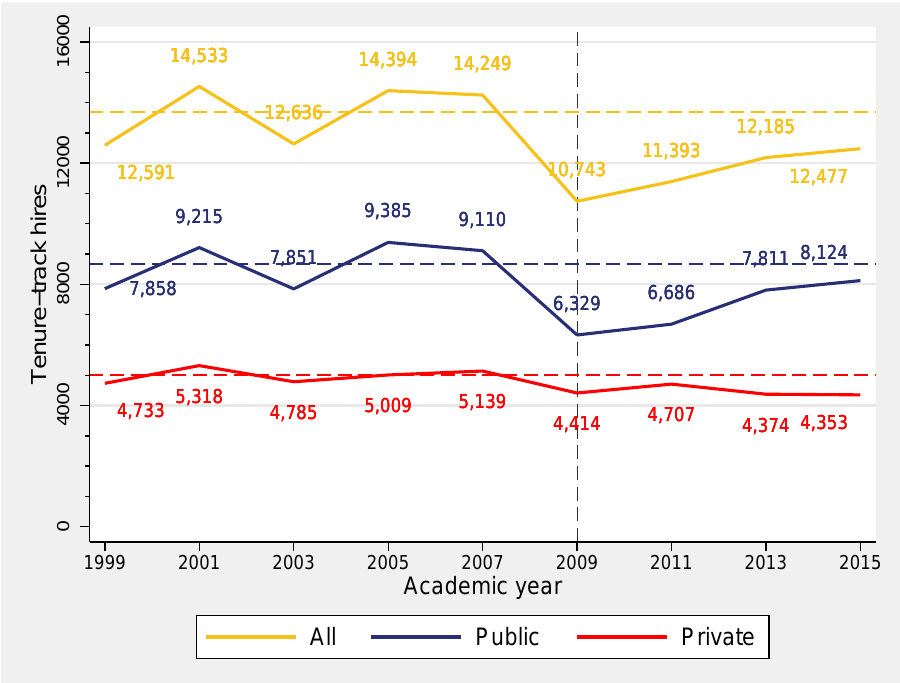
Figure 1: Tenure-track hires in public and private institutions. Dotted horizontal lines denote pre-recession (1999 to 2007) averages. Dotted vertical line denotes the year 2009, the first year that we see a contraction in new tenure-track hiring due to the Great